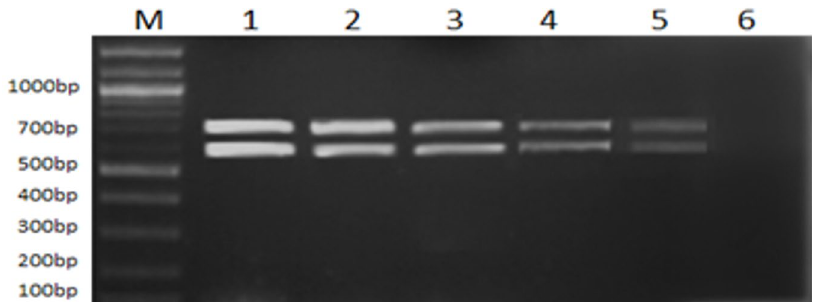
Fig. 2. Sensitivity analysis of Multiplex PCR with different template concentrations of Lipl32 and Lipl21 . Lane M: 100bp Marker, 1: 50ng/µL, 2: 12.5ng/µL, 3: 3.125ng/µL, 4: 780pg/µL, 5: 190pg/µL, 6: 47.5pg/µL .